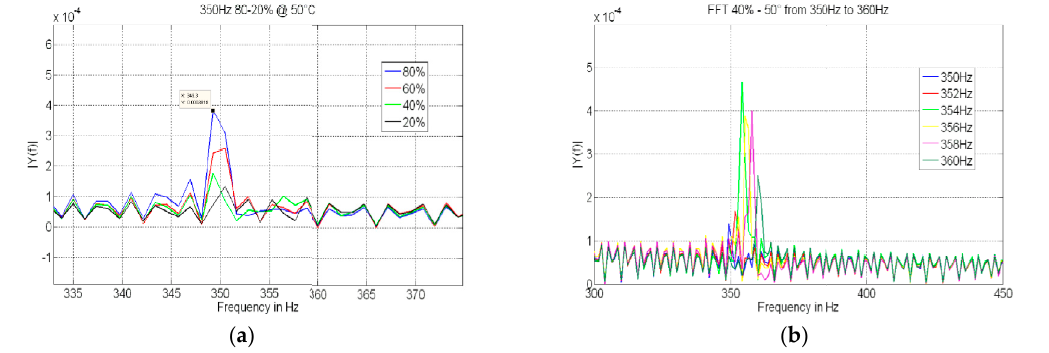
Figure 3. ( a ) FFT of the output of the bridge at 350 Hz (50 °C); ( b ) analysis around the mechanical resonance (at 40%, 50